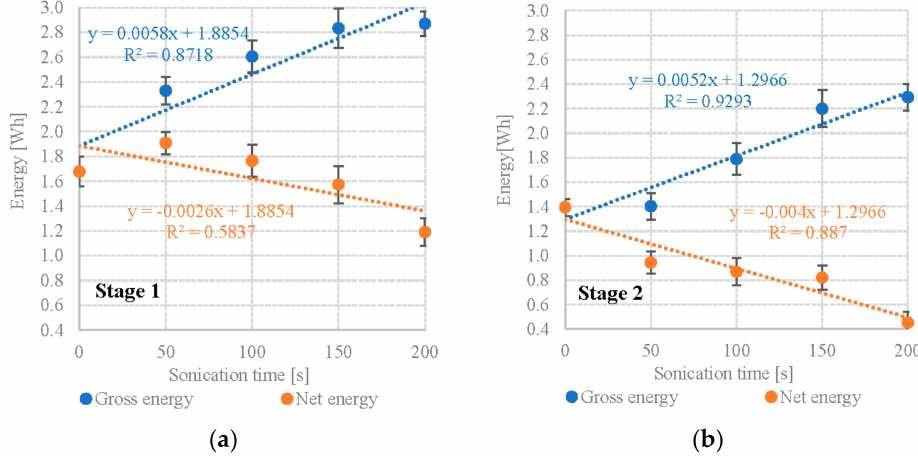
Figure 3. Correlations between UD exposure time and gross/net energy gain ( a ) S1— Scenedesmus sp., ( b ) S2— Pinnularia sp.